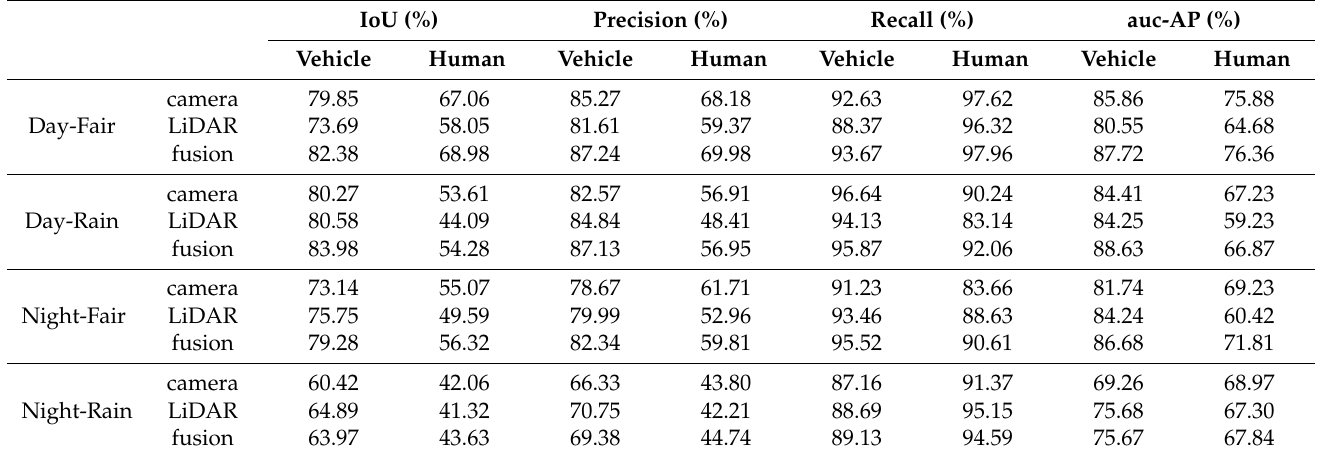
Table 6. Performance of the semi-supervised learning iseAuto baseline models.